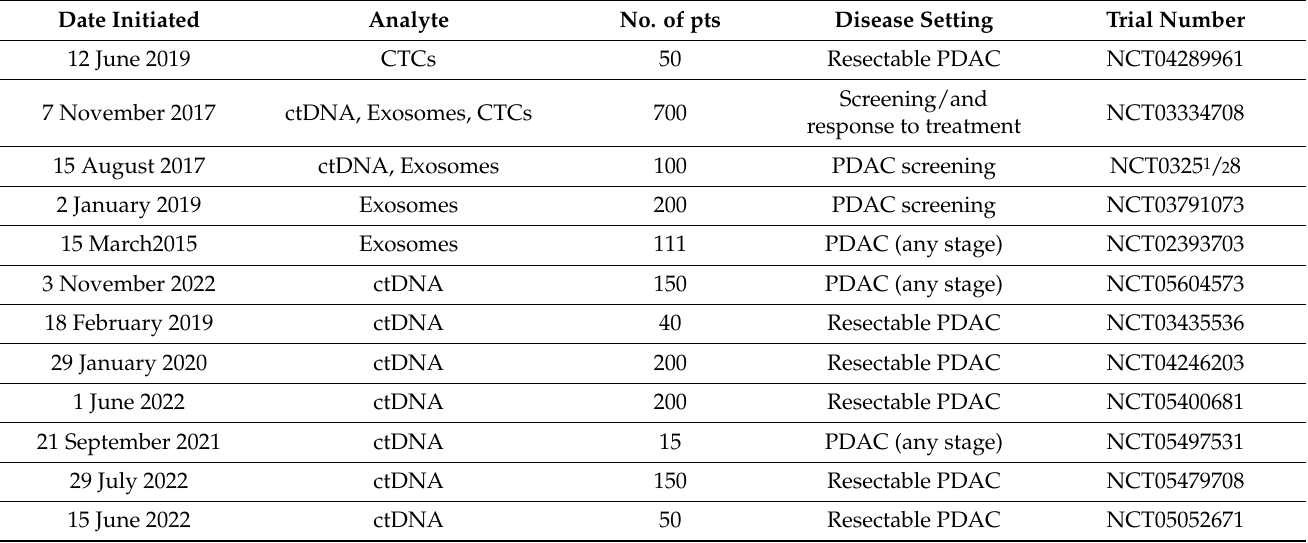
Table 4. Ongoing prospective clinical trials with primary outcomes evaluating the utility of liquid